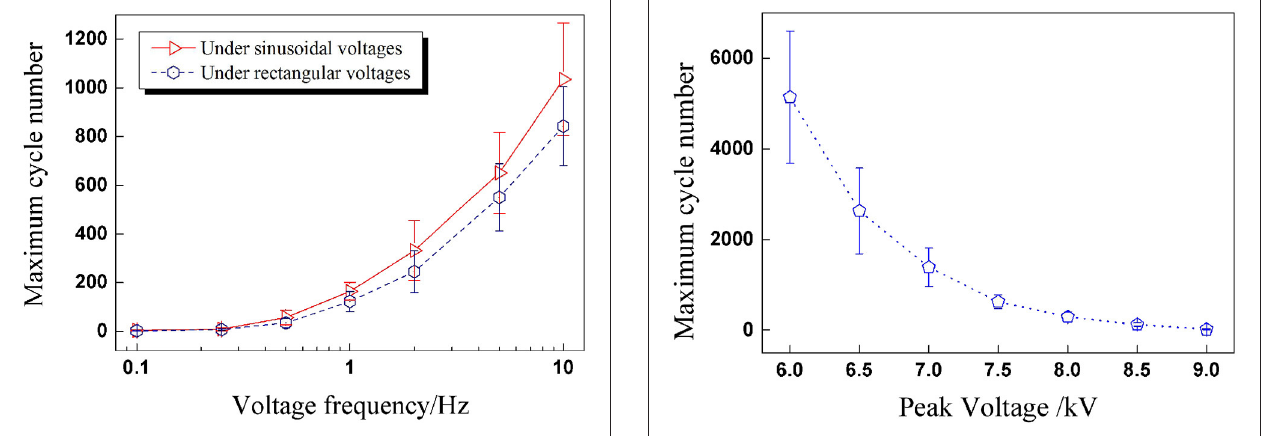
FIGURE 7 | The maximum cycle numbers of DEAs under sinusoidal and rectangular voltages with different frequencies (the effective voltage value is 4.24 kV).